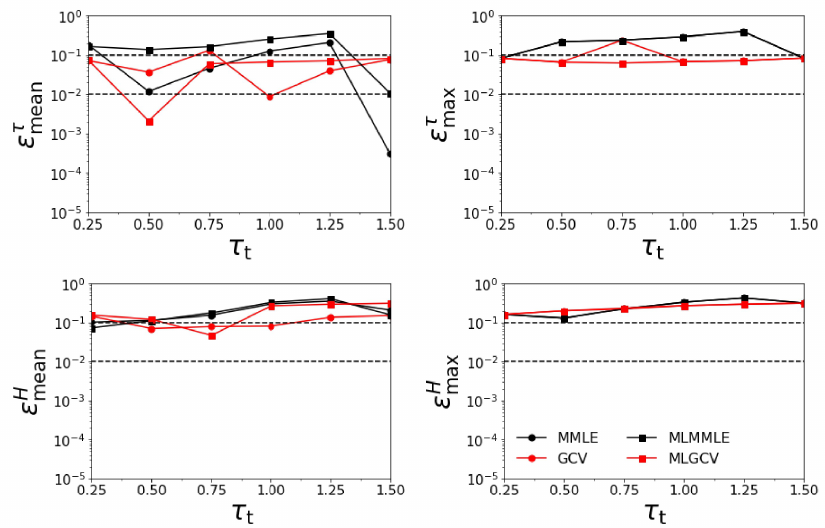
Figure 3. Relative errors ε τ mean , ε τ max , ε H mean , and ε H max versus τ t for H t = 3.0 km. All aerosol models except the exact one are involved in the retrieval.